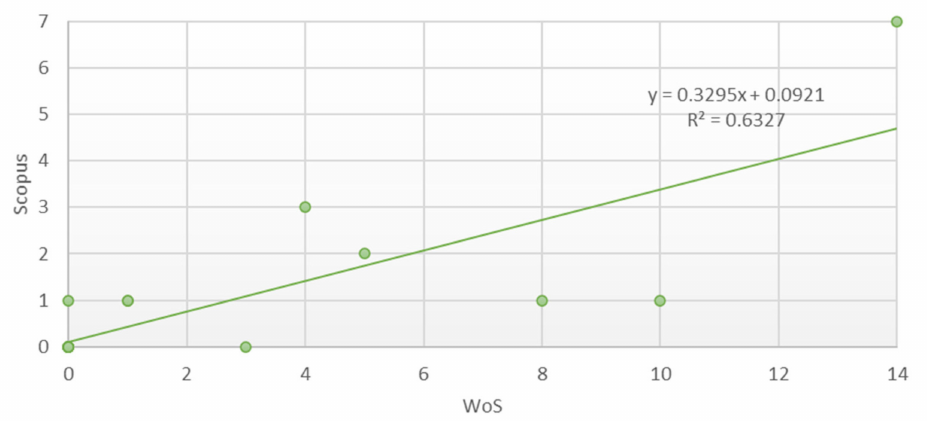
Figure 5. Correlation between the number of articles published per year in WoS and Scopus. Source: Own elaboration.